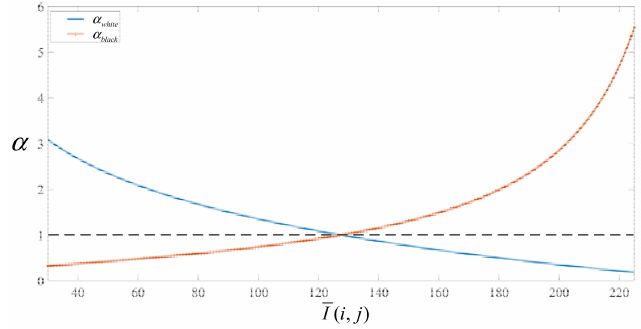
Figure 2. The α value